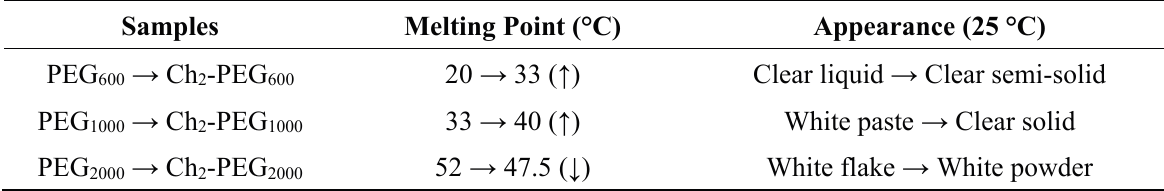
Table. 1. The melting points and appearances of Ch 2 -PEG n . The melting point was recorded as the midpoint value in the melting temperature range to facilitate